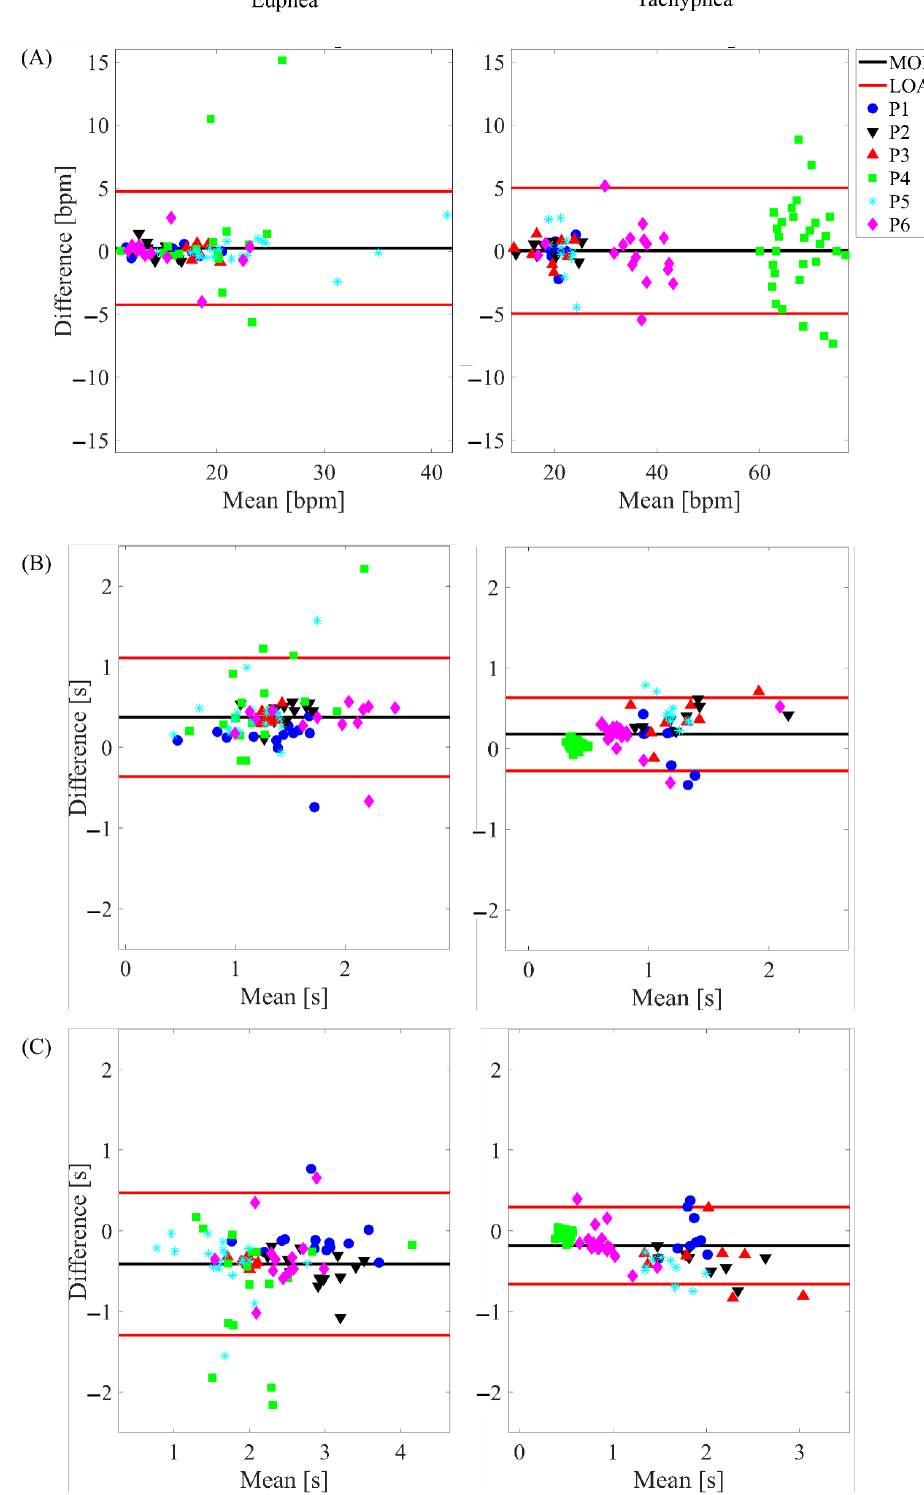
Figure 6. Bland-Altman plots depicting the estimated ( A ) f r , ( B ) t i and ( C ) t e on the total respiratory signal in eupnea and tachypnea